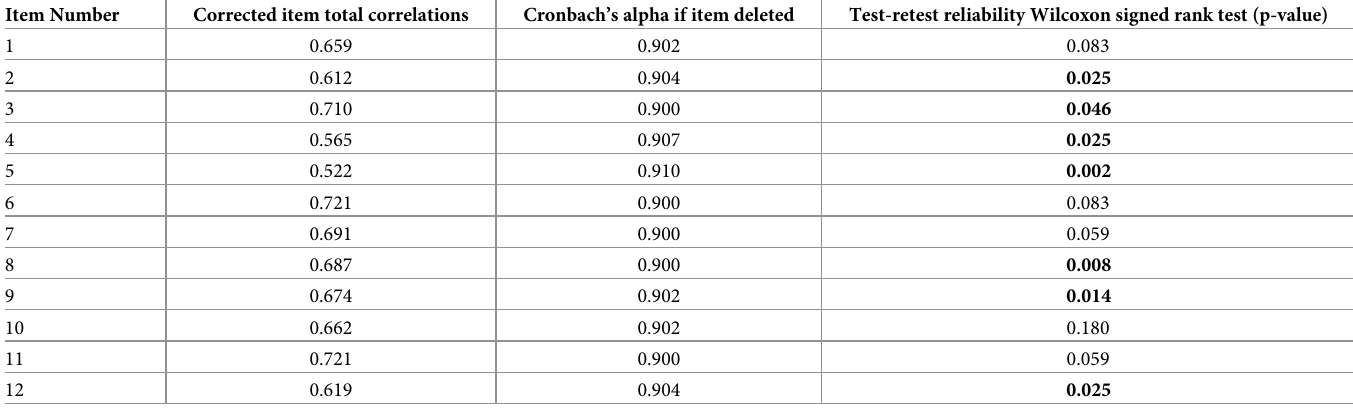
Table 5. Reliability analysis of